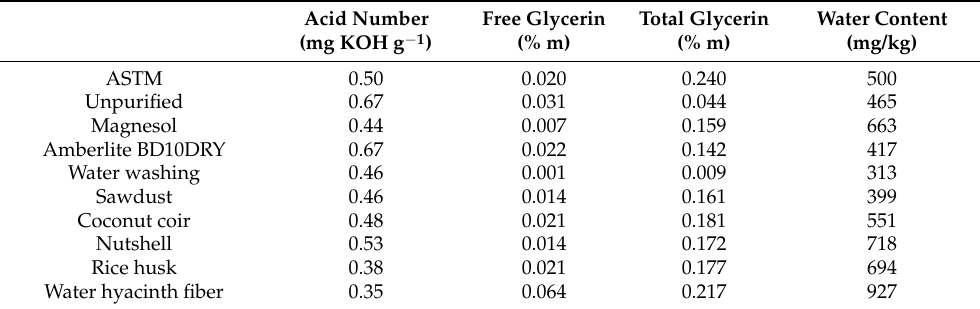
Table 1. Biodiesel quality analysis under different purification methods. The variation coefficient was less than 5 % except for Amberlite BD10DRY in the case of total glycerin.